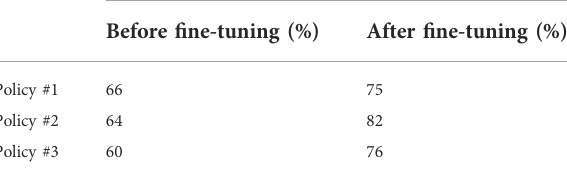
TABLE 5 Policy Fine-Tuning Results (the best three policies from the imitation learning step). Success rate (with perception